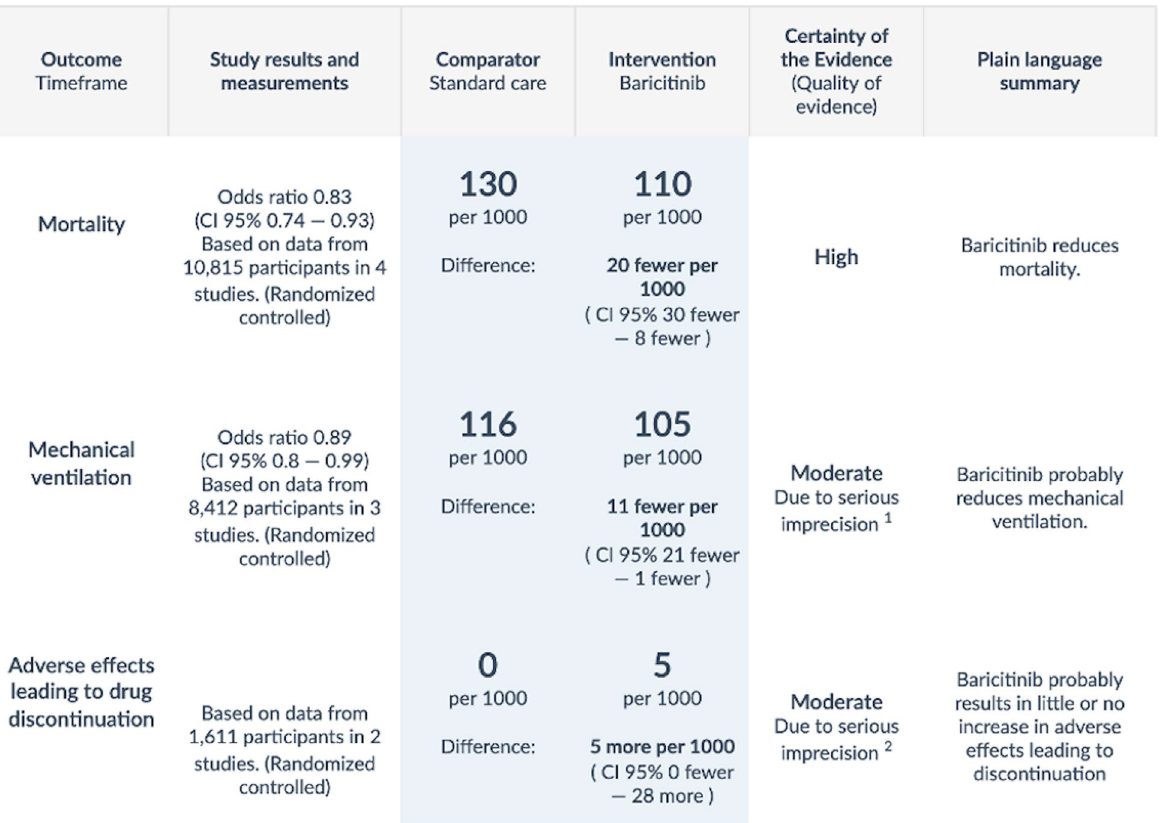
Fig. 1 World Health Organization summary of findings table evaluating baricitinib in severe or critical COVID-19 infection